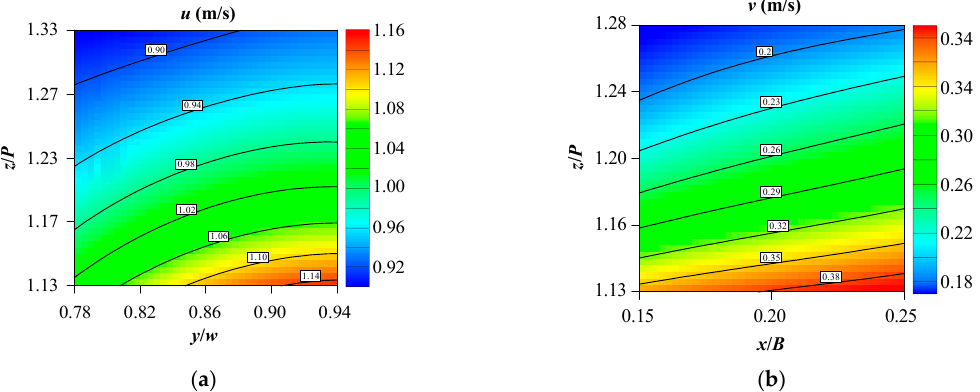
Figure 14. Velocity contours in Rec-B2 ( H o / P = 0.7): ( a ) u -component above the upstream normal wall (P6, upstream view); ( b ) v -component above the side wall (P5, side view).